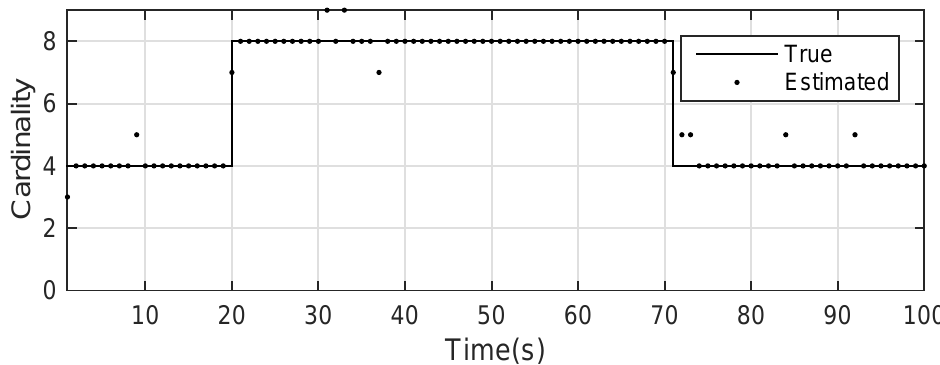
Figure 11. The estimated number of targets by Gibbs GLMB